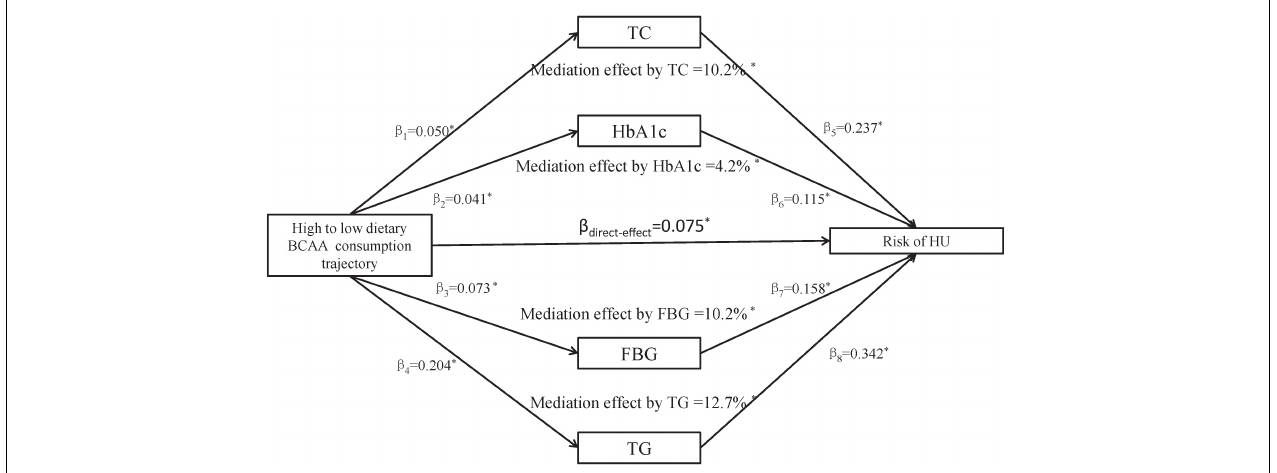
FIGURE 2 | Mediation effects of TC, HbA1c, FBG, and TG on the association between dietary branched-chain amino acids (BCAA) consumption trajectories and risk of HU. Data were standardized regression coefficients with adjustment for covariates; ∗ p < 0.05 for coefficients different from 0. TC, Total cholesterol; HbA1c,